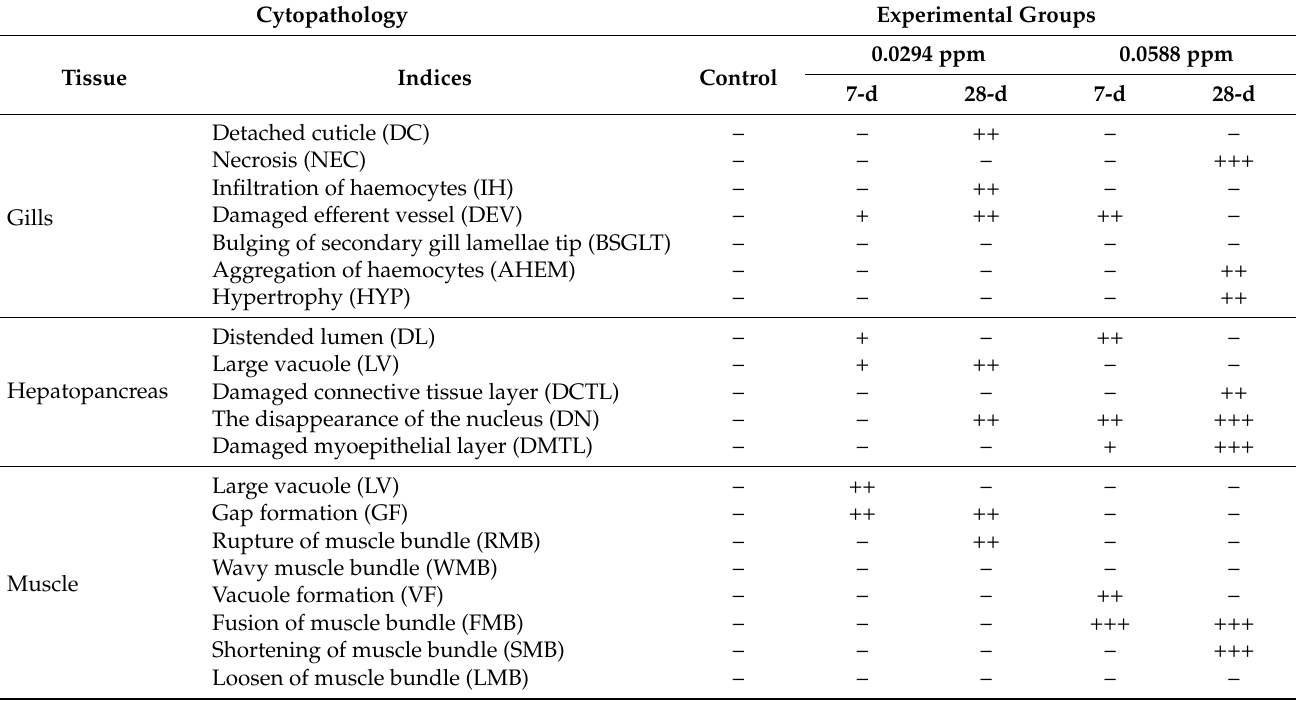
Table 1. Cytopathologic observations of mangrove crab, E. tetragonum , after the duration of 7-d and 28-d to sublethal concentration of insecticide Chlorpyrifos (0.0294 and 0.0588 ppm). Legend: –, none (0%); +, mild (<10%); ++, moderate (10 to 50%); +++, severe (>50%).